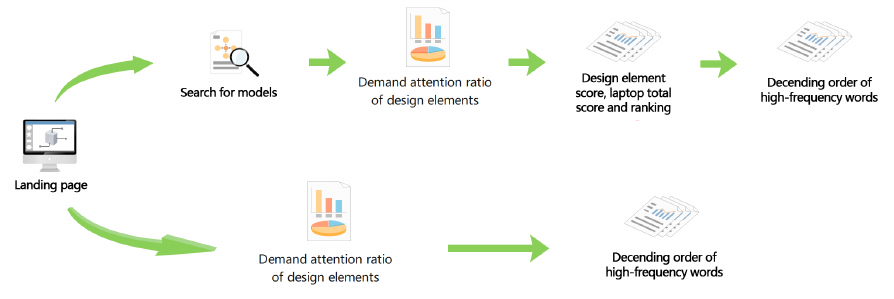
Figure 4. Interaction logic diagram of visualization